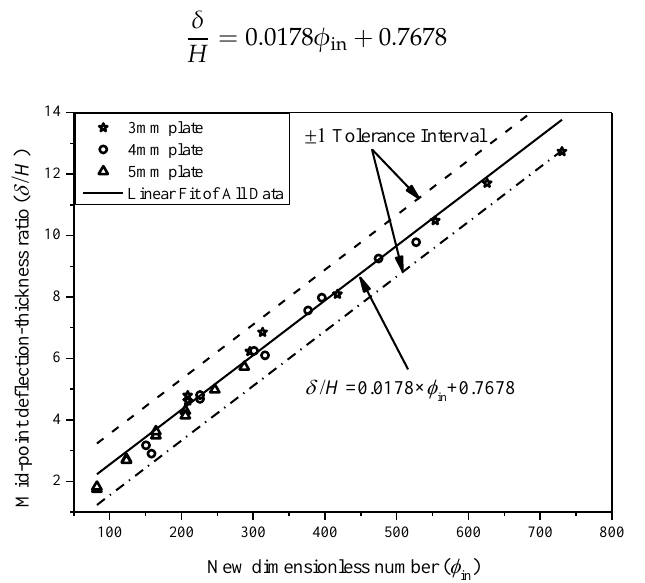
Figure 2. The measured deflection–thickness ratio versus the new dimensionless number ( φ in ) for the confined blast tests.